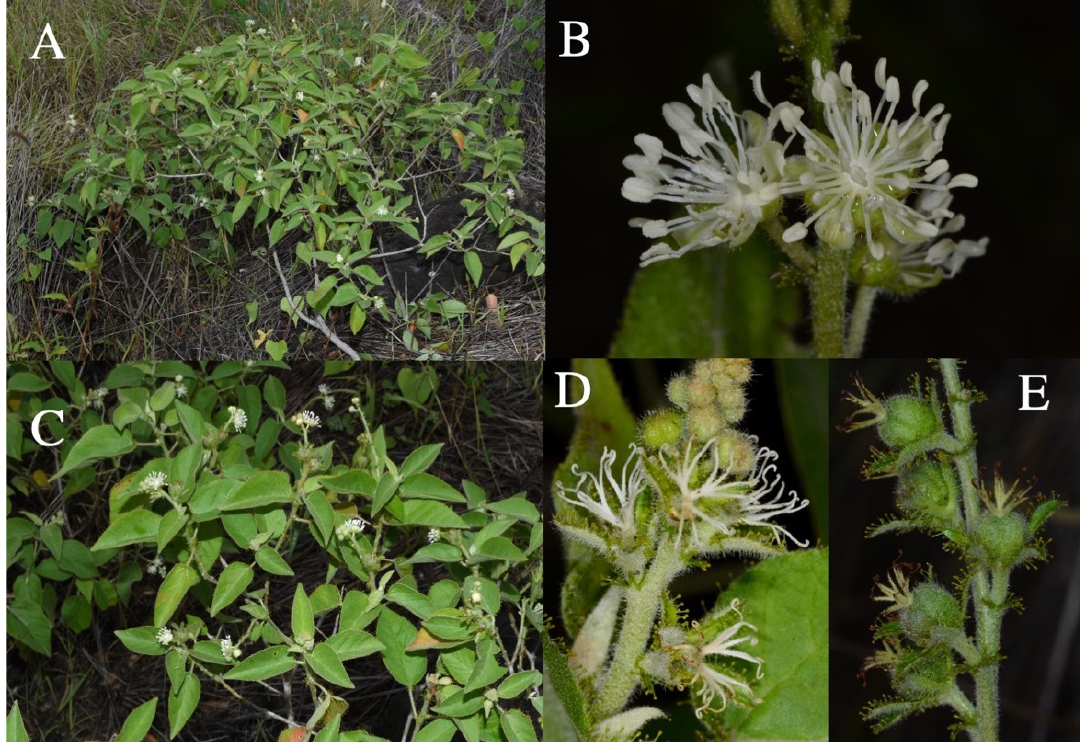
Figure A3. Croton ciliatoglandulifer. ( A ) Habit. ( B ) Staminate flowers. ( C ) Flowering branches. ( D ) Inflorescence with open pistillate flowers and staminate buds. ( E ) Young